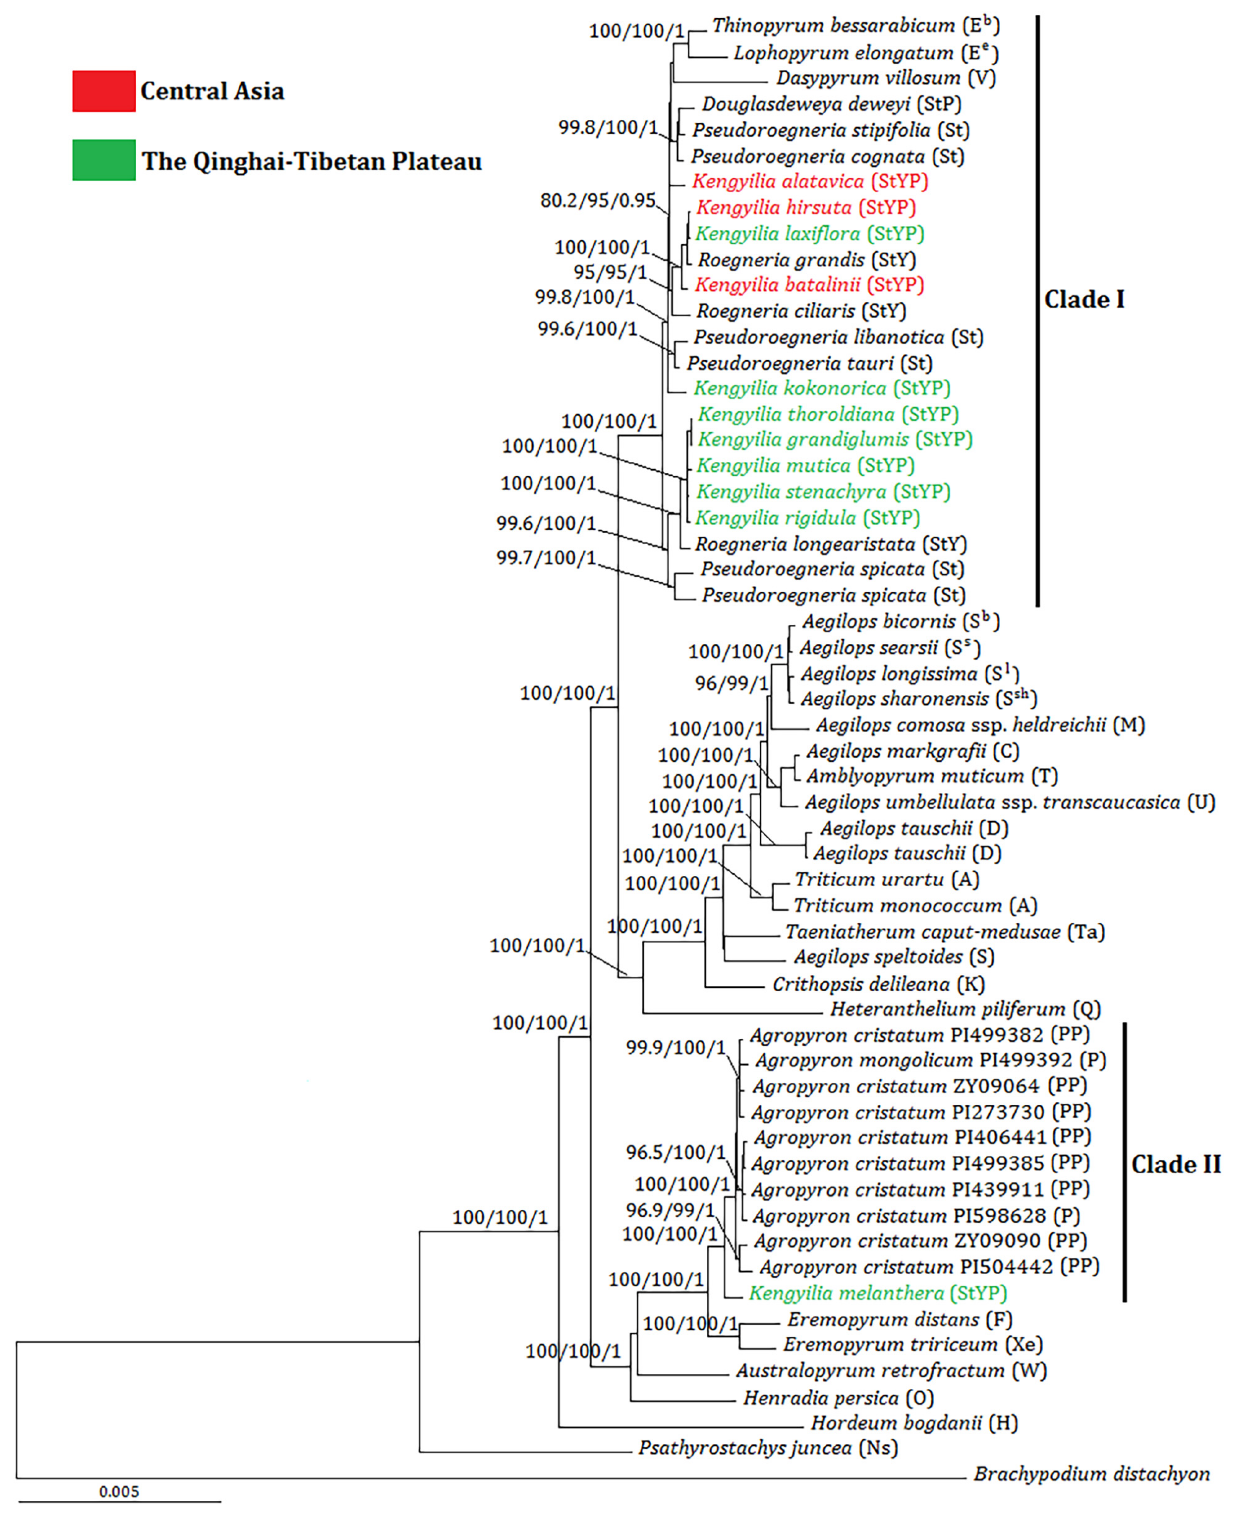
Frontiers in Plant Science |